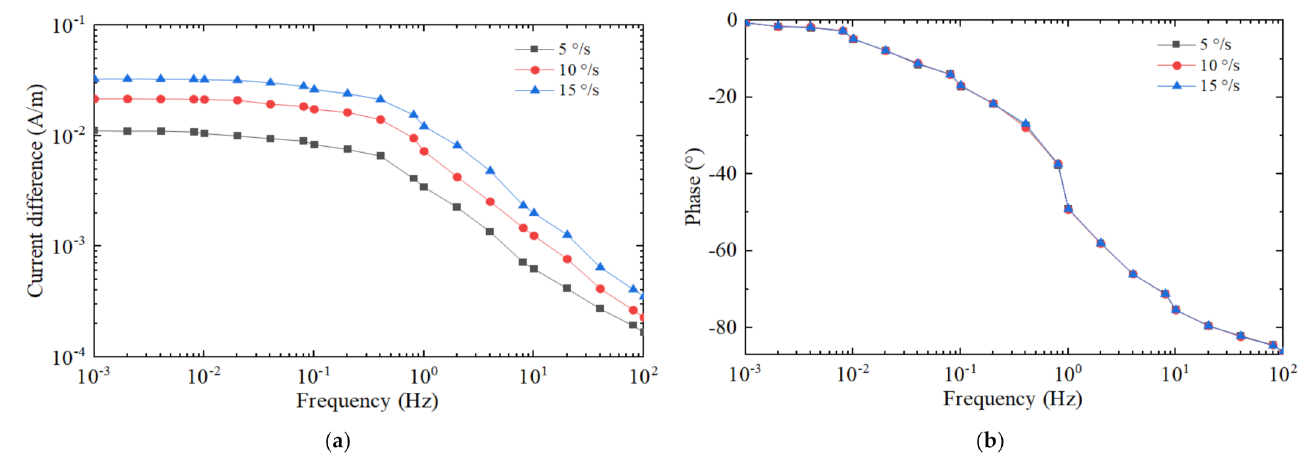
Figure 6. The output responses at different external angular rates in the frequency domain. The external angular rate is 5 ◦ , 10 ◦ and 15 ◦ , respectively. ( a ) Amplitude–frequency response. ( b ) Phase–frequency response.